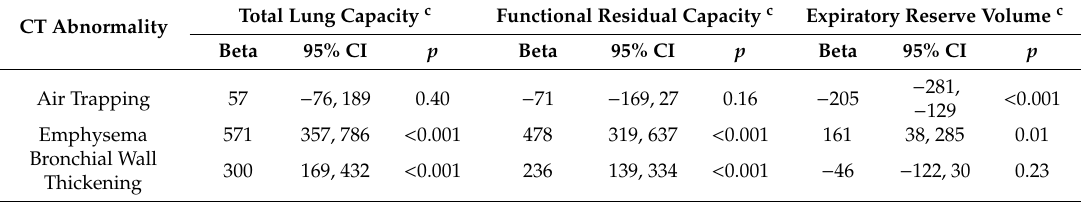
Table 7. Multivariable linear models assessing the association of CT abnormalities with lung volumes a,b . CT